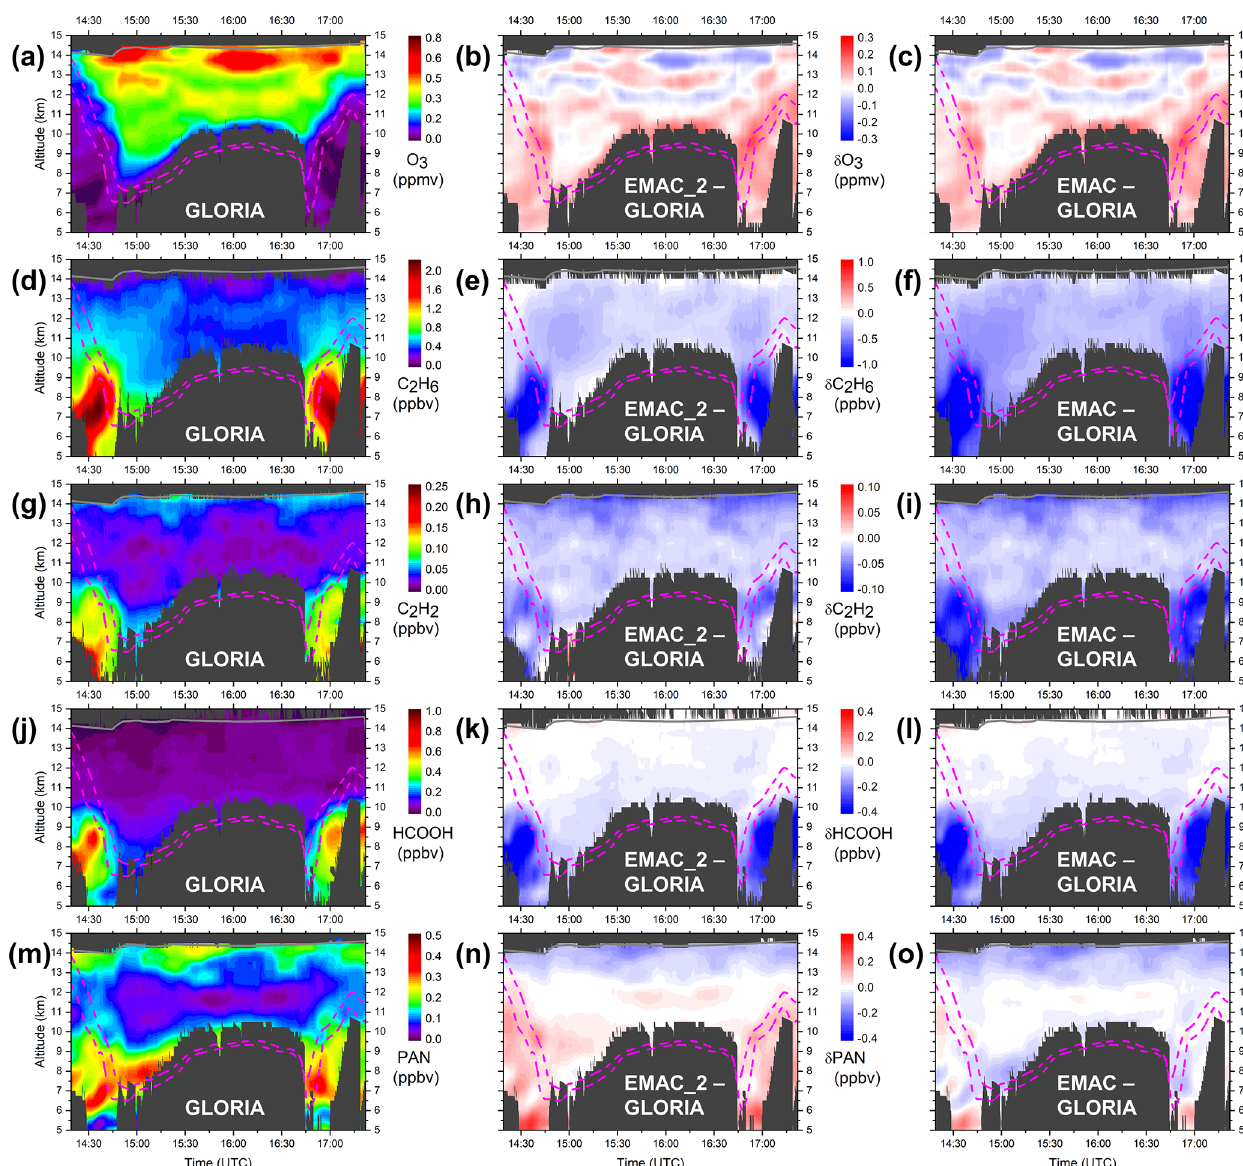
Figure 8. Horizontal and vertical VMR distributions of GLORIA (temporally smoothed, left column), EMAC_2 (enhanced NMVOC emis- sions) minus GLORIA (middle column), and EMAC (standard NMVOC emissions) minus GLORIA (right column) of (a–c) O 3 , (d–f) C 2 H 6 , (g–i) C 2 H 2 , (j–l) HCOOH, and (m–o) PAN, as seen on 13 September 2017. Annotation as per Fig.